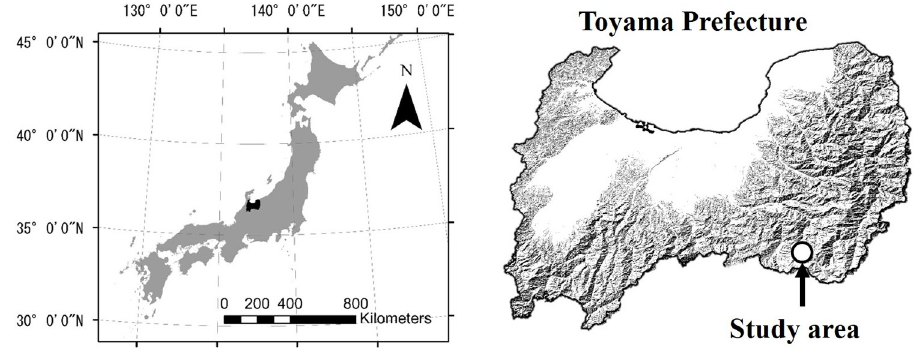
Fig 1. Location of the study area on Mt. Taro in Chubu-Sangaku National Park, at the western edge of the Northern Alps, Toyama Prefecture, Japan. The maps are reproduced from digital maps published by the Ministry of Land, Infrastructure, Transport and Tourism (https://nlftp.mlit.go.jp/ksj/gml/datalist/KsjTmplt-N03-v3_0.html) (left) and a digital elevation model (DEM; 10 m mesh) published by the Geospatial Information Authority of Japan (https:// fgd.gsi.go.jp/download/menu.php) (right).